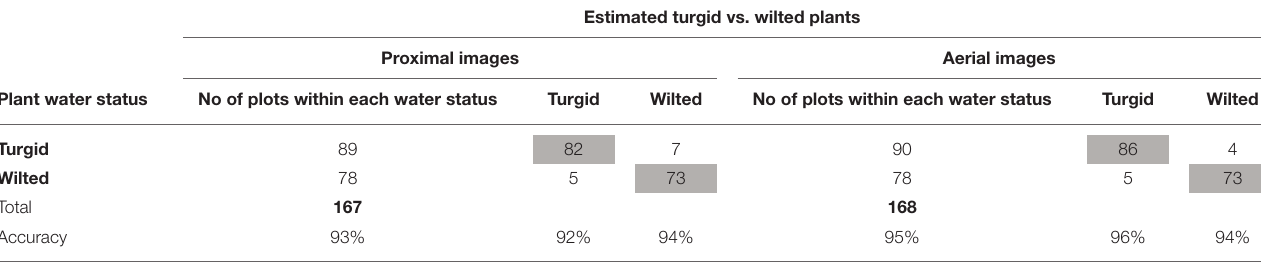
TABLE 9 | Wilting accuracy matrix with the number of manual wilting scores (2019) on a visual scale at the left and outside the table and the count of image-derived wilting scores in the